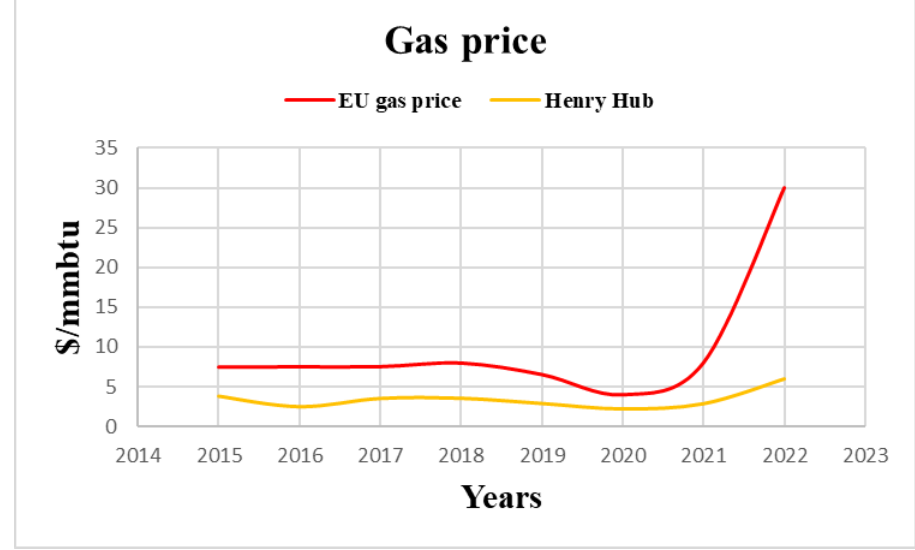
Figure 2. LNG prices in the European Union (EU) and Henry Hub markets.